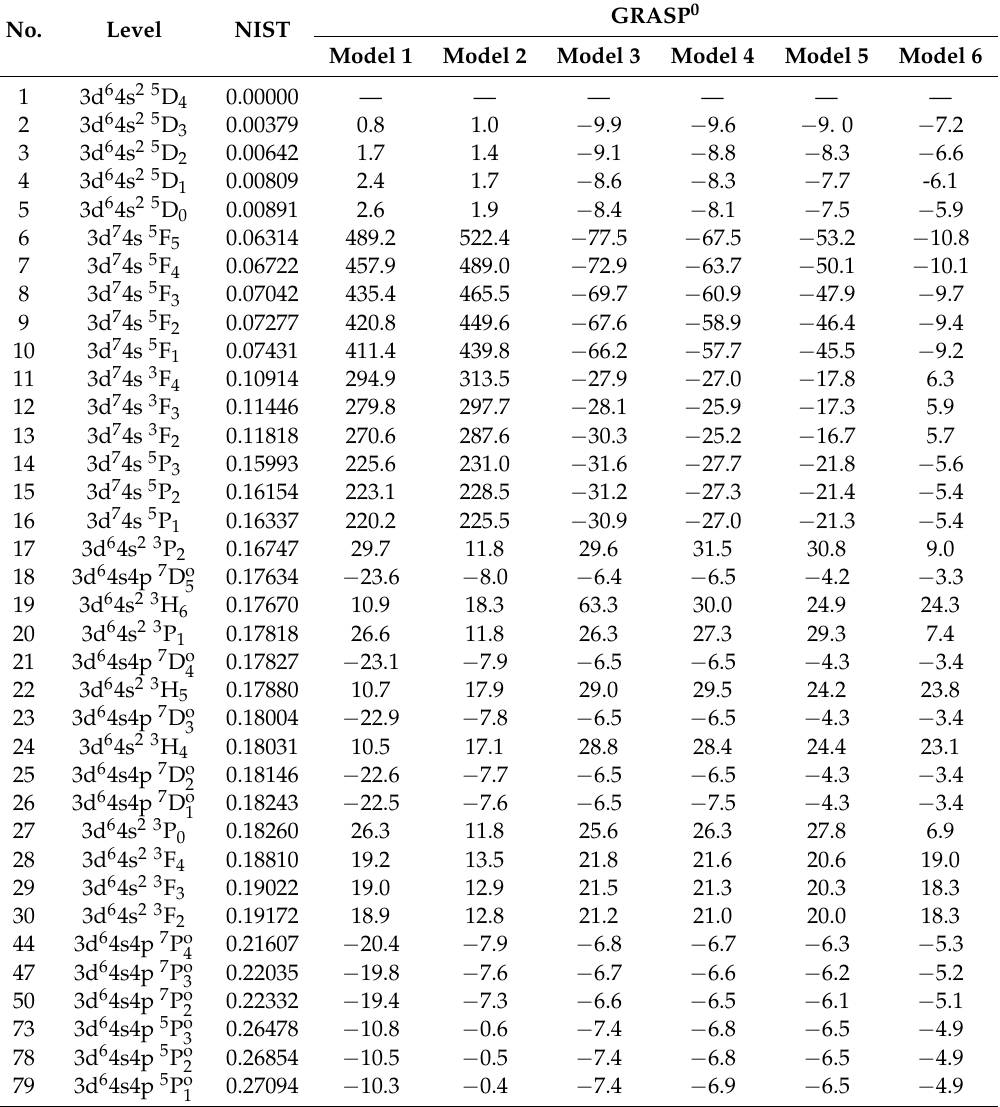
Table 2. Percentage differences of the energy levels from different GRASP 0 ( General-Purpose Relativistic Atomic Structure Program ) structures with the experimental NIST ( National Institute of Standards and Technology )